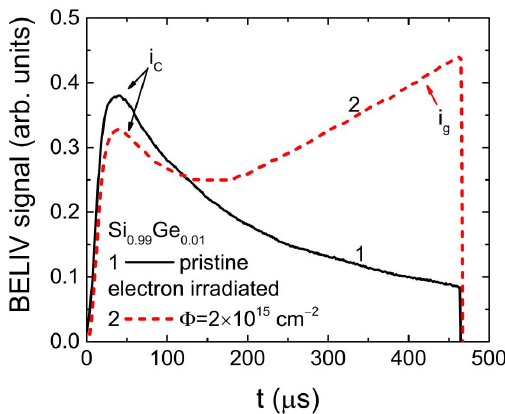
Figure 2. The BELIV transients recorded in pristine and electron irradiated Si 0.99 Ge 0.01 diodes using LIV pulses of U P = 12 V and τ PL = 470 µ